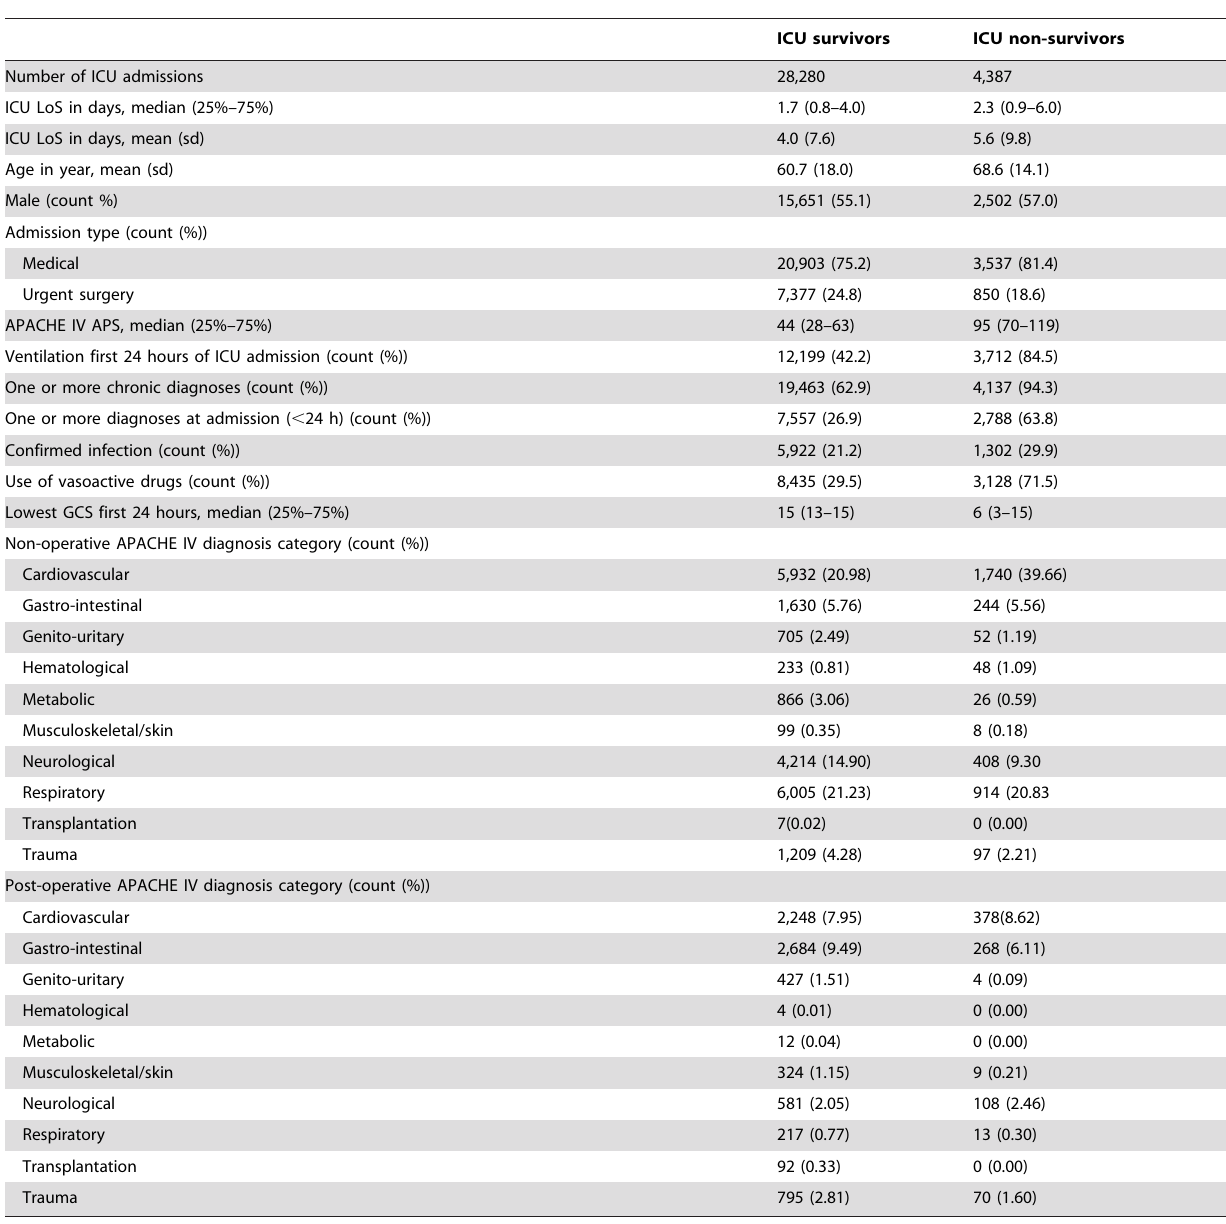
Table 1. Demographics of ICU admissions included in the analysis, for ICU survivors and ICU non-survivors separately (n